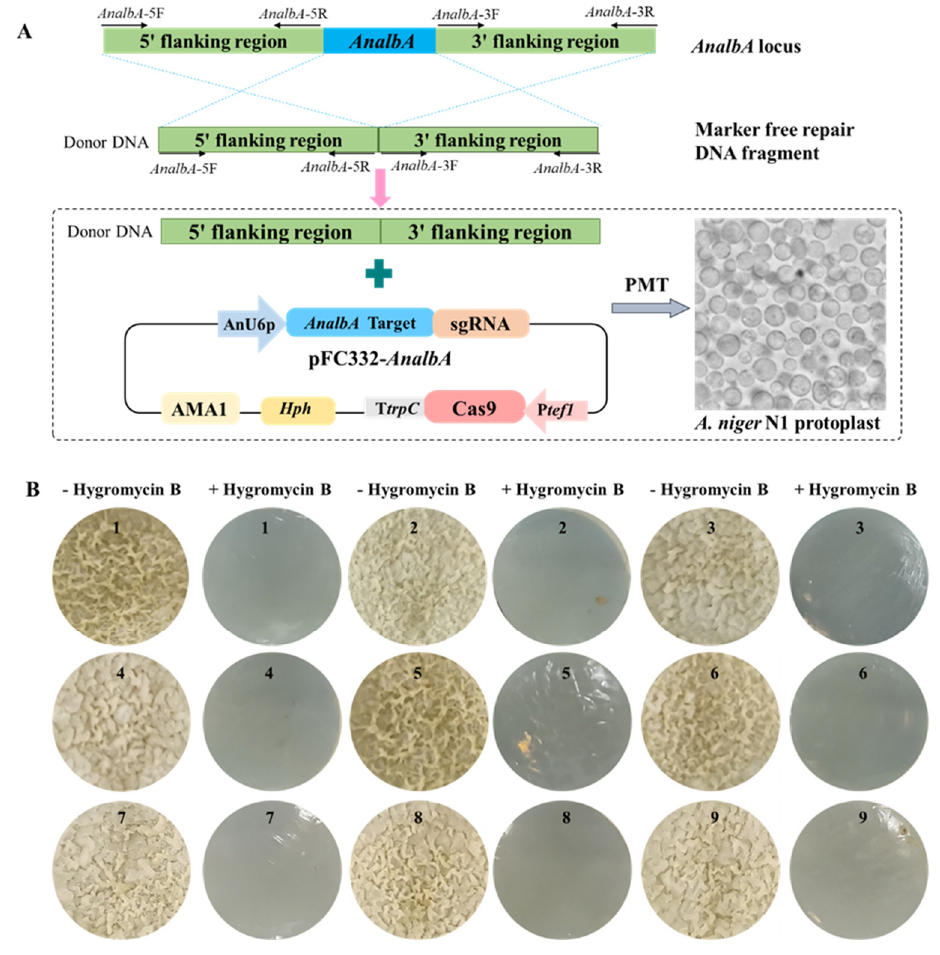
Figure 7. Generation of the marker-free AnalbA -knockout mutants of A. niger N1 by autonomously replicating vector harboring Cas9- and sgRNA-encoding genes and a hygromycin sensitivity test of AnalbA -knockout mutants before and after plasmid removal. ( A ) pFC332- AnalbA and the donor DNA fragment transformed into A. niger N1 by PMT. AnU6p is the promoter of A. niger N1; Ptef1 is the promoter of translation elongation factor gene tef1 from A. nidulans ; the cas9 gene encoding Streptococcus pyogenes Cas9 was codon-optimized for expression in A. niger ; AMA1, self-replicating extrachromosomal AMA1 elements from A. nidulans ; Hph , hygromycin resistance gene. ( B ) Phenotypes of nine AnalbA -knockout transformants with loss of pFC332- AnalbA plasmid with and without hygromycin pressure. Mutant with AnalbA knockout and lost pFC332- AnalbA plasmid failed to grow in medium containing 50 µg/mL hygromycin.